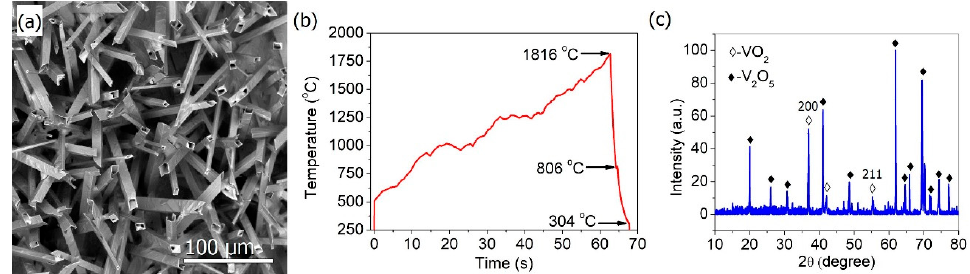
Figure 2. Characteristics of as-fabricated single-crystalline VO 2 microtube arrays on V 2 O 5 substrate: ( a ) SEM image, ( b ) temperature vs. time curve during fabrication, and ( c ) XRD pattern.